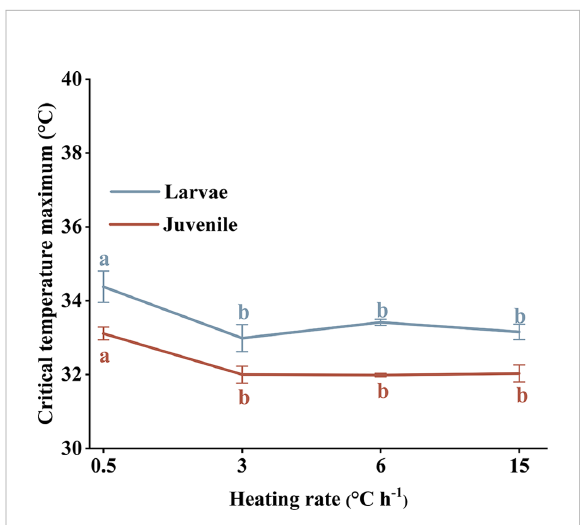
FIGURE 6 Larvae and juveniles Larimichthys crocea critical temperature maxima (CTMax) subjected to different heating rates. Labeled means without a common letter differ ( P <